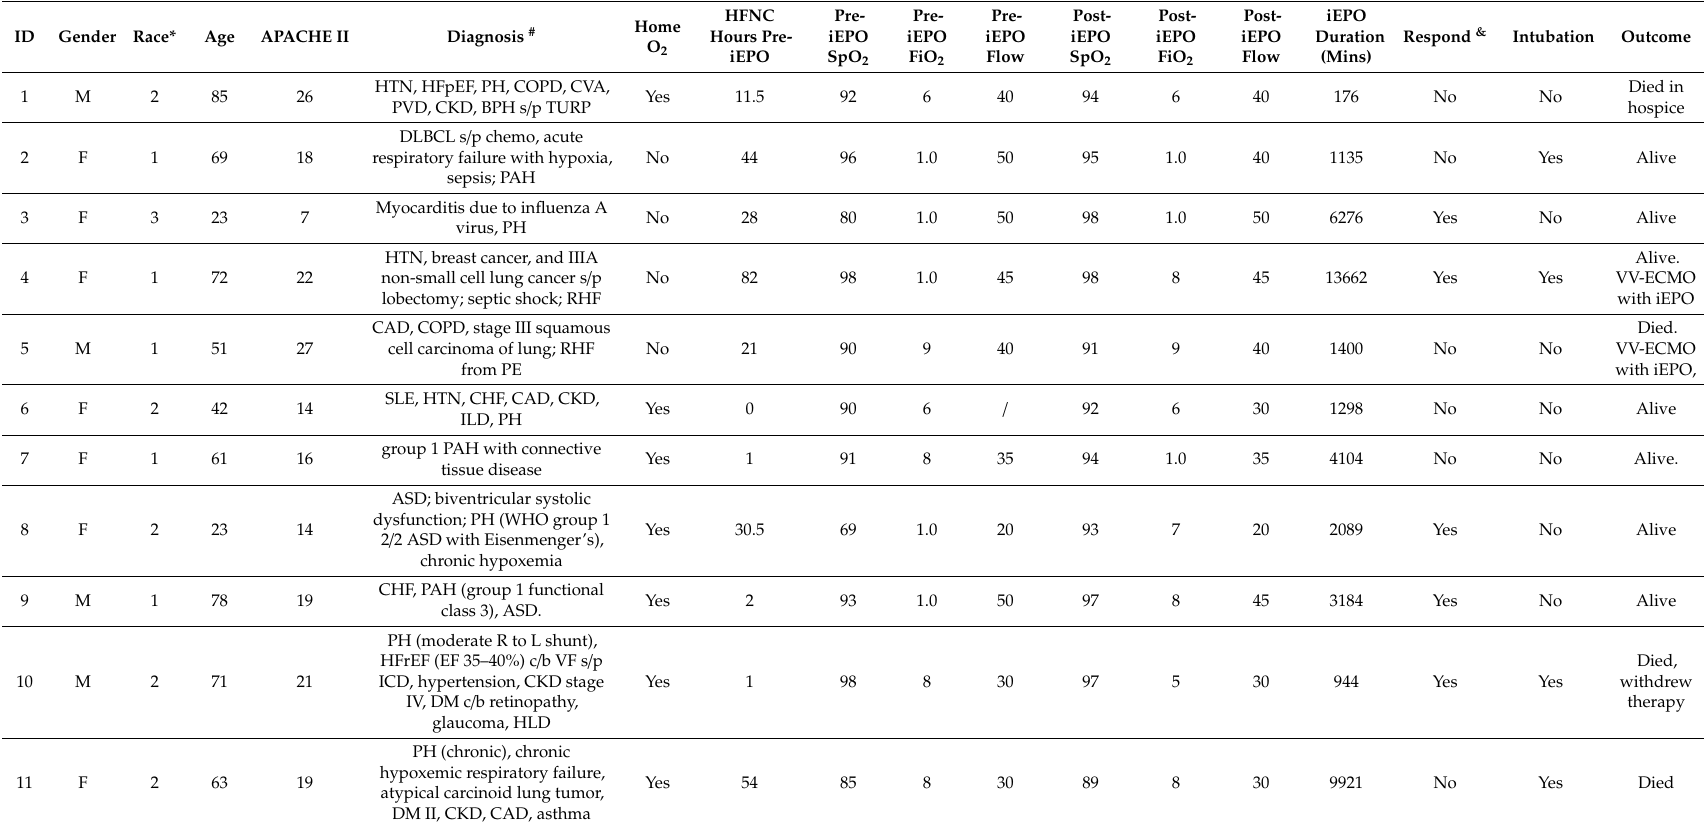
* 1 Caucasian; 2 African American; 3 Hispanic; # HTN: hypertension; HFpEF: heart failure with preserved ejection fraction; PH: pulmonary hypertension; COPD: chronic obstructive pulmonary disease; CVA: cerebrovascular accident; PVD: peripheral vascular disease; BPH s / p TURP: benign prostatic hyperplasia status post transurethral resection of the prostate; DLBCL: di ff use large B-cell lymphoma; PAH: pulmonary arteria hypertension; RHF: right heart failure; CAD: coronary artery disease; PE: pulmonary embolism; SLE: systemic lupus erythematosus; CHF: congestive heart failure; CKD: chronic kidney disease; ILD: interstitial lung disease; ASD: atrial septal defect; HFrEF: heart failure with reduced ejection fraction; VF: ventricular fibrillation; ICD: implantable cardioverter defibrillator; DM: diabetes mellitus; HLD: hypersensitivity lung disease; & A subject was considered a responder to iEPO if their SpO 2 / FIO 2 increased by >